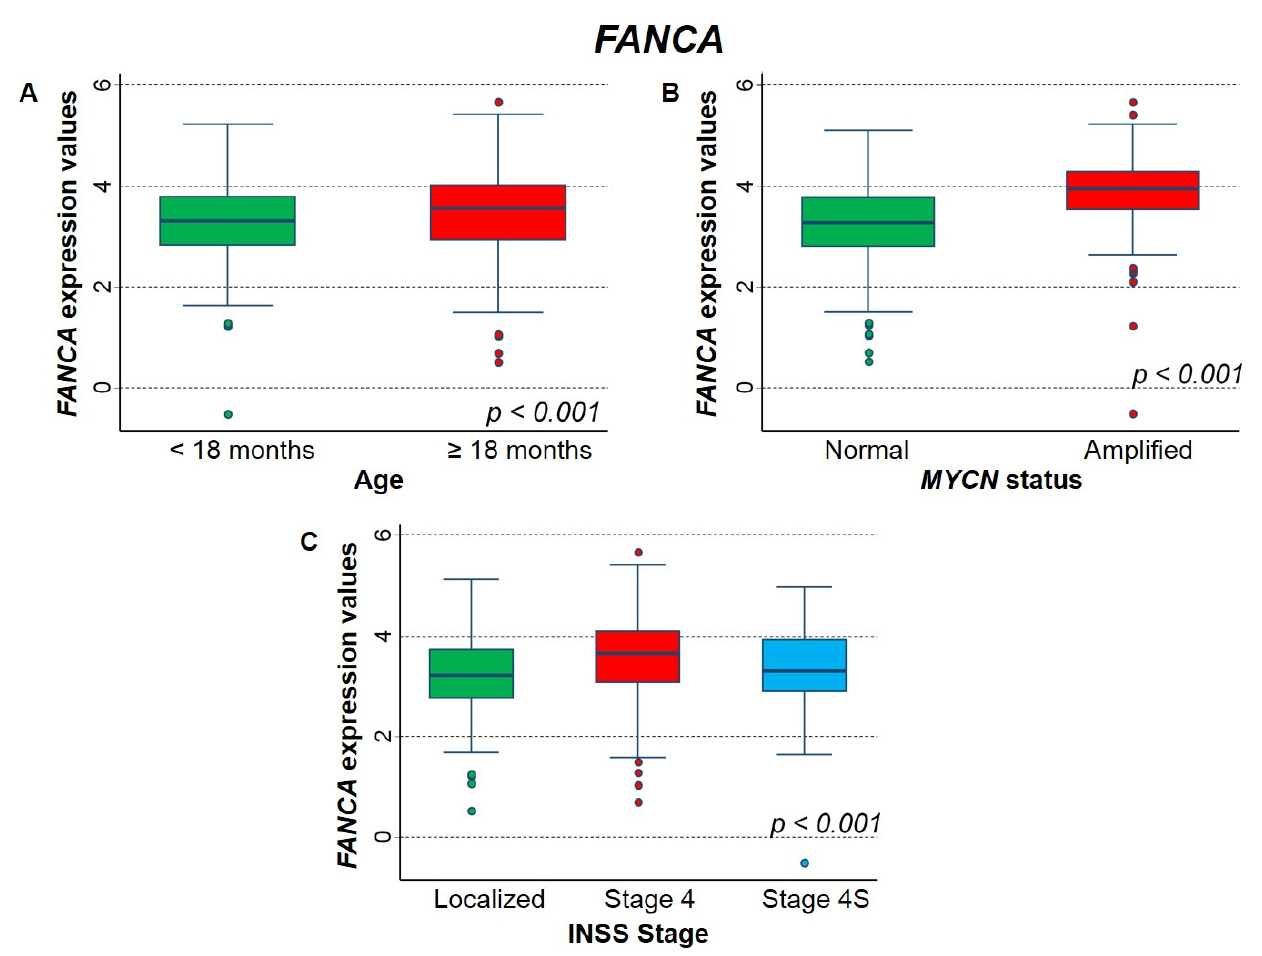
Figure 8. Association between FANCA gene expression and the main patient characteristics at diagnosis evaluated on the entire cohort. ( A ) Age; ( B ) MYCN status; ( C ) INSS stage. Table 4. Survival of the whole cohort of patients with NB in relation to FANCA gene-expression values, evaluated by the multivariable Cox regression model. Event Free